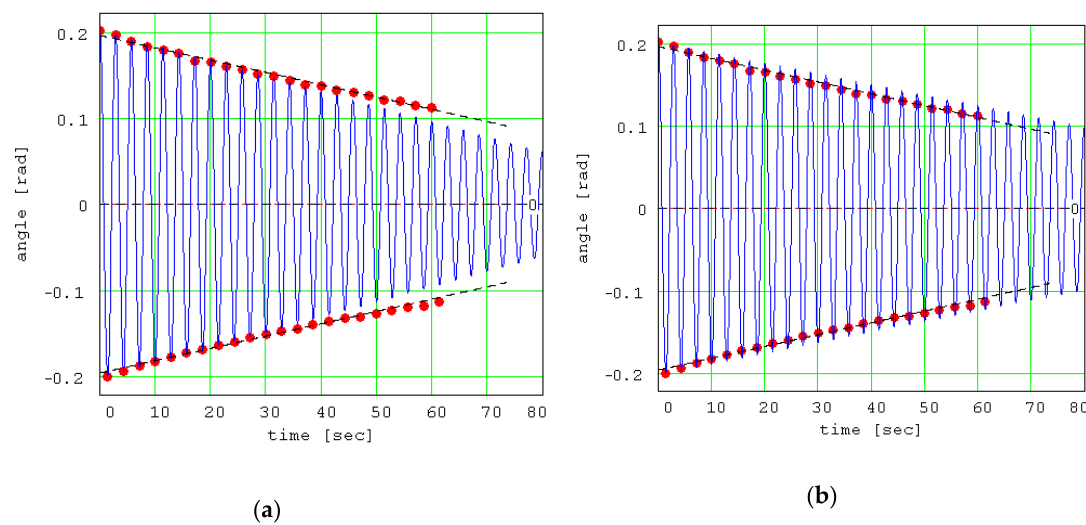
Figure 16. Theoretical signals for di ff erent values of the dimensional coe ffi cient of rolling friction: ( a ) Theoretical signal for s r = 3.7 × 10 − 6 m; ( b ) Theoretical signal for s r = 2.7 × 10 − 6